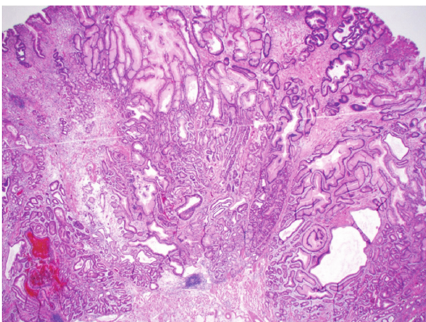
Figure 5: Hematoxylin and eosin stain: high power view of polyp showing dilated glands admixed with fibrosis and inflammation.